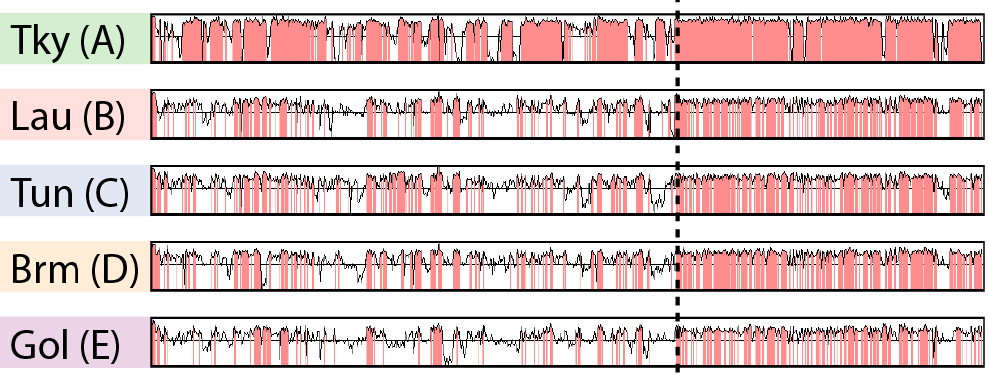
Figure 2. Genomic rearrangements in marseilleviruses. Each horizontal line represents a viral genome, namely: tokyovirus (Tky), melbournevirus (Mel), cannes 8 virus (Ca8), marseillevirus (Mrs), marseillevirus shanghai (Sha), noumeavirus (Nou), kurlavirus (Kur), port-miou virus (Por), lausannevirus (Lau), tunisvirus (Tun), brazilian marseillevirus (Brm) and golden marseillevirus (Gol), grouped and color-coded according to the clade it belongs to (shown on le left). Genes encoded on the forward strain are shown in dark colors and genes on the reverse strand in light colors. Vertical red and blue lines represent homologous genes between a pair of genomes. Red lines correspond to genes that are in the same direction, while blue lines represent inverted genes. The dashed vertical line separates the region prone to genomic rearrangements (on the left) from the one relatively depleted in rearrangements (on the right).